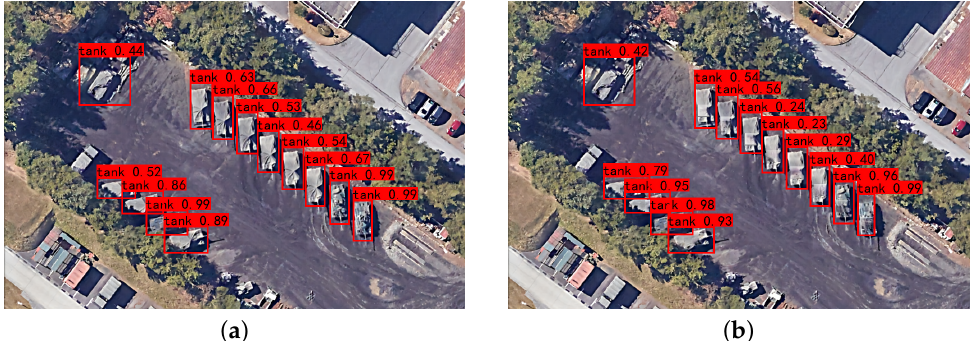
Figure 7. ( a ) detection result of YOLOv3 on clean images; ( b ) detection result of YOLOv3 after defending with our algorithm under adversarial patch